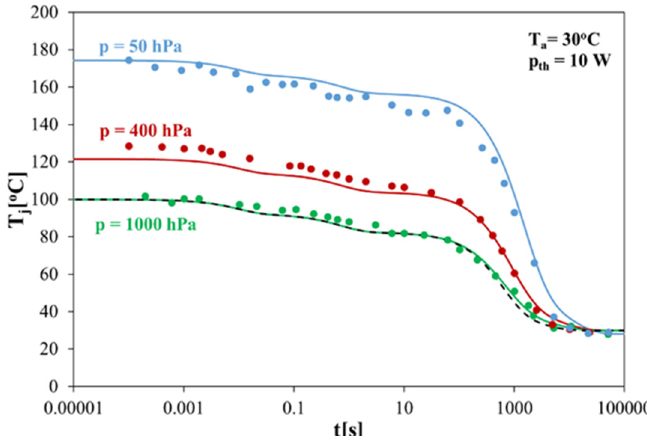
Figure 7. Measured and computed dependences of thermal resistance of the tested diode on atmospheric pressure for two values of ambient temperature.